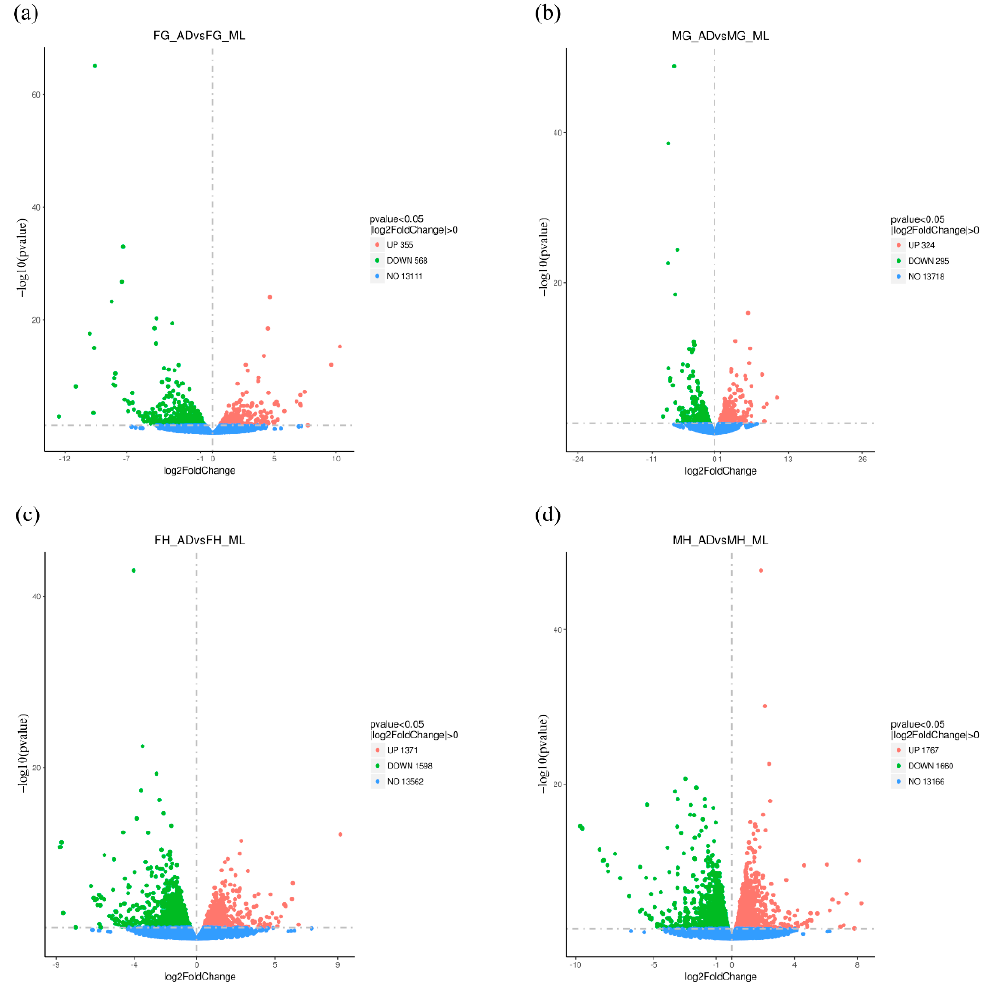
Figure 2. Volcano plot of DEGs in silkworm fed AD and ML. Volcano plot for pair wise comparison for ( a ) FG_ADvsFG_ML, ( b ) MG_ADvsMG_ML, ( c ) FH_ADvsFH_ML and ( d ) MH_ADvsMH_ML. Horizontal oridinate represents the fold change of gene expression, and the vertical ordinate represents the statistical significance of the change. Number of DEGs expressions (normalized to Log2 fold change) are displayed on the right side of each picture based on a p -adj cut-off of <0.05. The red plot represents a differentially upregulated gene, a green plot represents a differentially downregulated gene, and the blue plot means a gene that does not show differential expression.